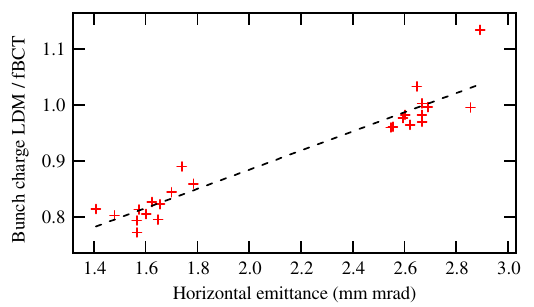
FIG. 8. Dependence of the measured bunch current on trans- verse bunch size for 24 bunches. The graph shows the ratio of the bunch charge measured by the LDM to the bunch charge measured by the fast beam current transformer (FBCT) against horizontal emittance, along with a linear fit. Measurement with beam during a dedicated run with 12 low-emittance and 12 high- emittance bunches, with much larger variation in emittance than during normal operation. The LDM detector was off centered horizontally so that it received more light from bunches with larger horizontal beam